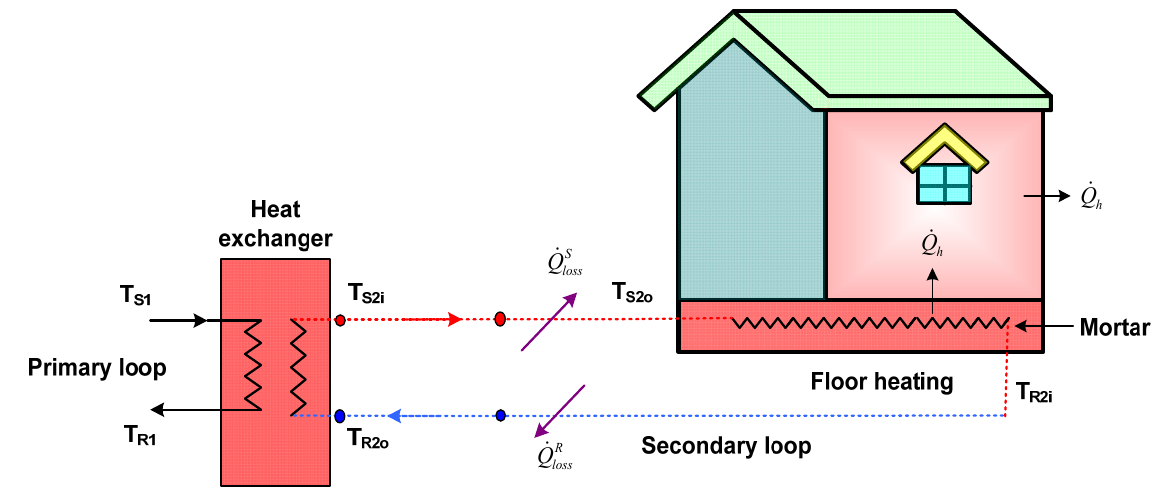
Figure 10. Schematic diagram of secondary loop of group energy heat supply